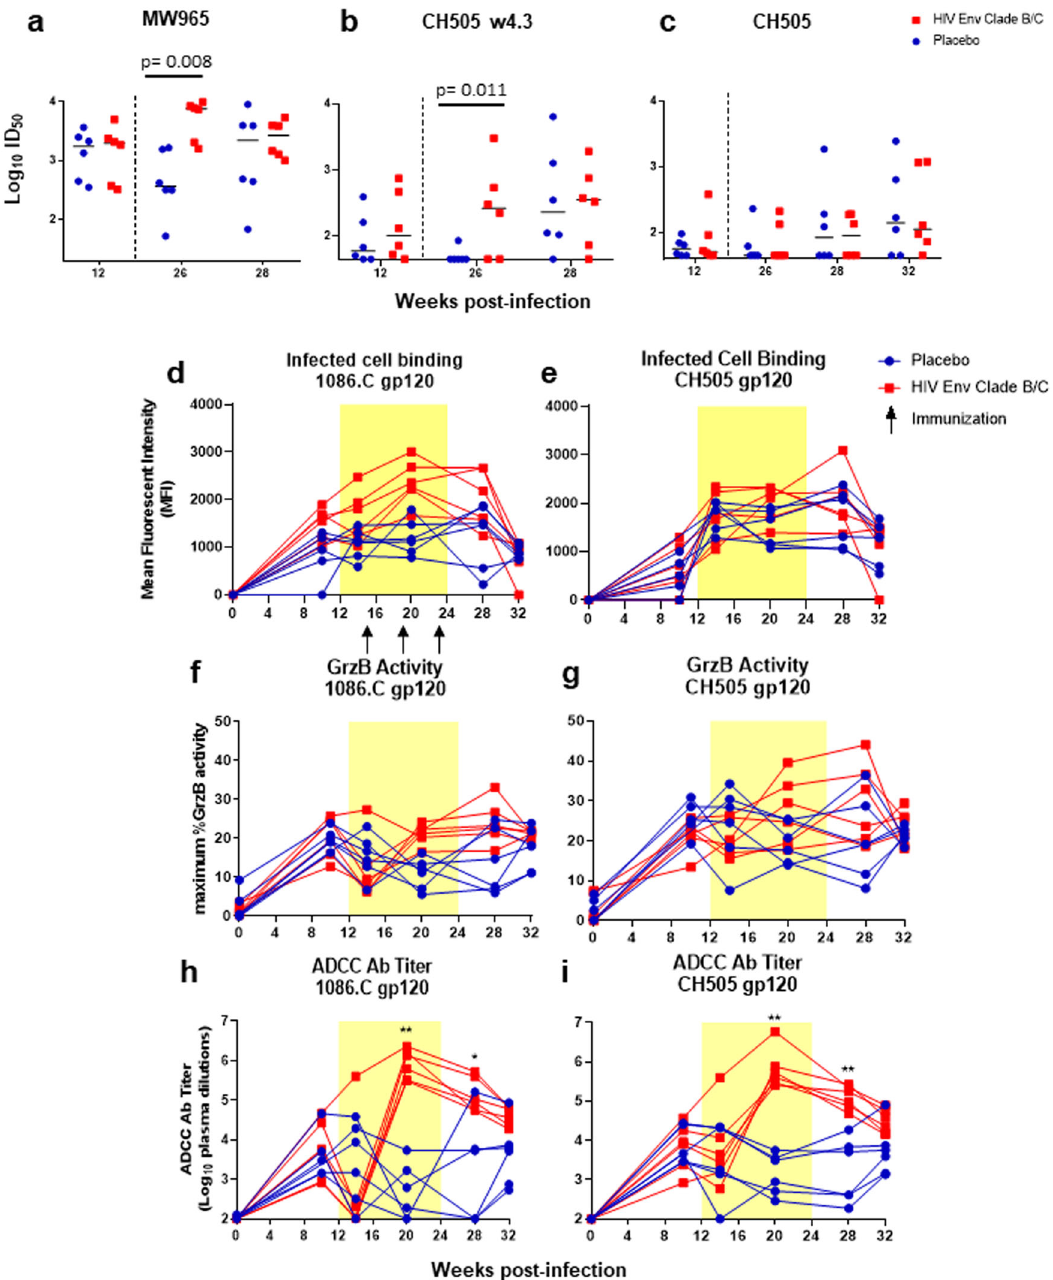
Fig. 4 Functional antibody responses elicited in vaccinated and placebo recipient SHIV-infected, ART-treated rhesus monkeys. Plasma neutralizing activity against tier 1 viruses, MW965 ( a ) and CH505 w4.3 ( b ) and the autologous CH505 ( c ) virus. Medians are indicated as horizontal lines, vertical dotted line indicates ART stop. Levels of infected cell binding expressed as Mean Fluorescent Intensity to a panel of HIV-1 1086.C or CH505.TF IMC-infected cells over time for each animal are shown ( d , e ). Maximum granzyme B activity ( f , g ) and the plasma dilution endpoint ADCC antibody titers ( h , i ) against 1086.C and CH505 gp120-coated target cells over time for each animal are shown. Statistical analyses were performed using Wilcoxon rank-sum tests with exact p -values to compare plasma IgG neutralization ( a – c ) and ADCC antibody titers ( h , i ) between vaccinated and placebo RMs, followed by FDR adjustments for multiple comparisons. *unadjusted p < 0.05, **unadjusted p < 0.01. FDR adjusted p -values are reported in the dot plots. See Supplementary Table 3 for both unadjusted p and FDR_p for all